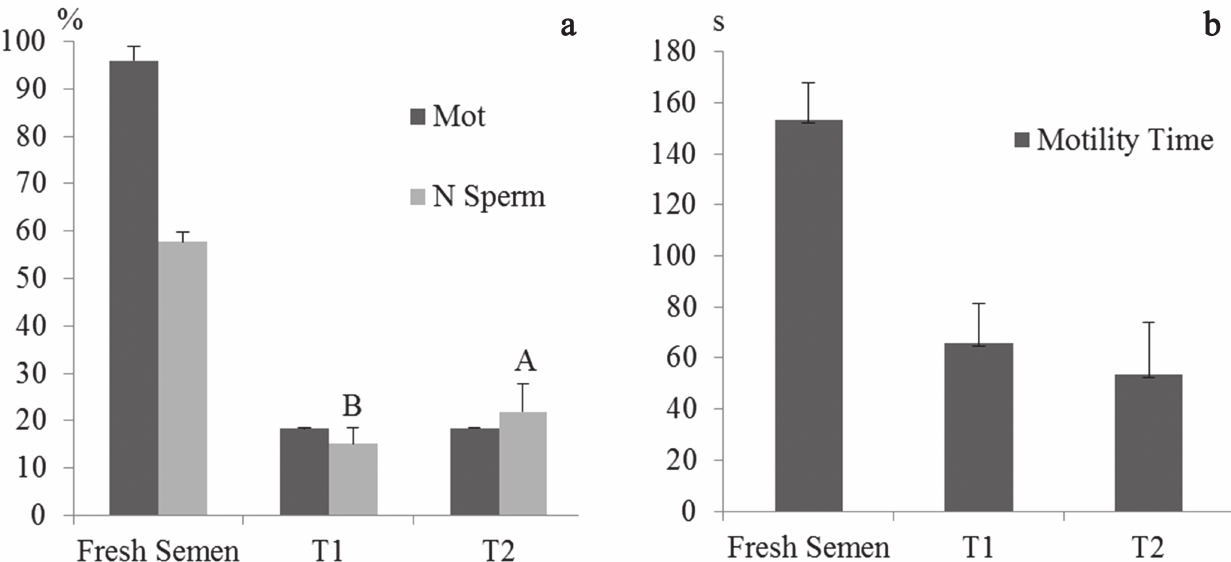
Fig. 1 . (a) Mean and standard deviation of Progressive Motility (Mot) and Normal Sperm (N Sperm) and (b) Motility Time (TMot) of Colossoma macropomum , fresh and frozen, with two extenders (T1 - Solution 1 and T2 - Solution 2). Evaluated using the Kruskal-Wallis non-parametric test.